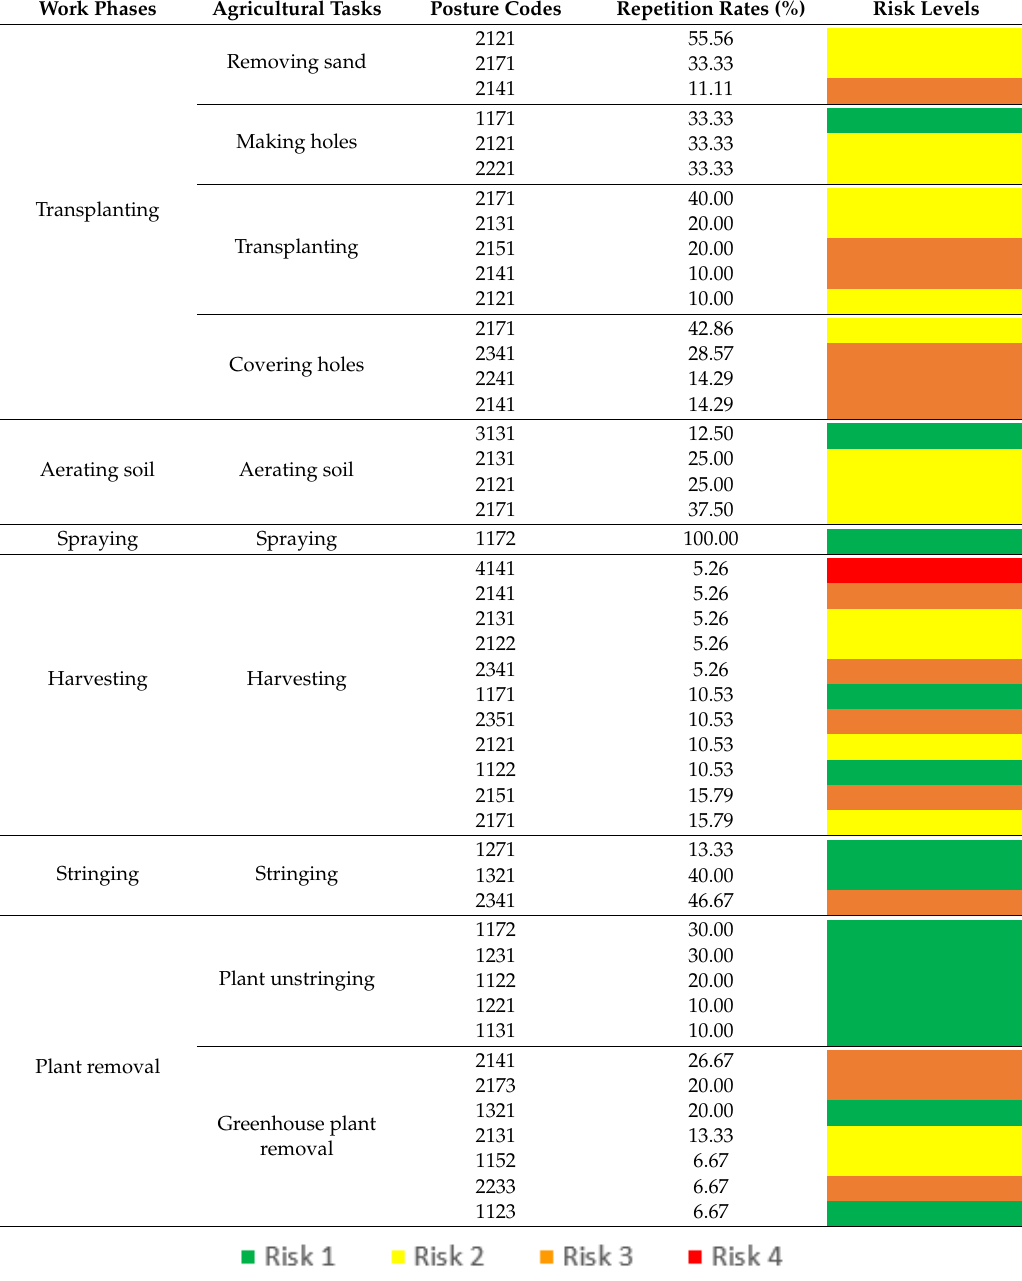
Table 4. Posture codes, repetition rates and risk levels according to agriculture tasks.